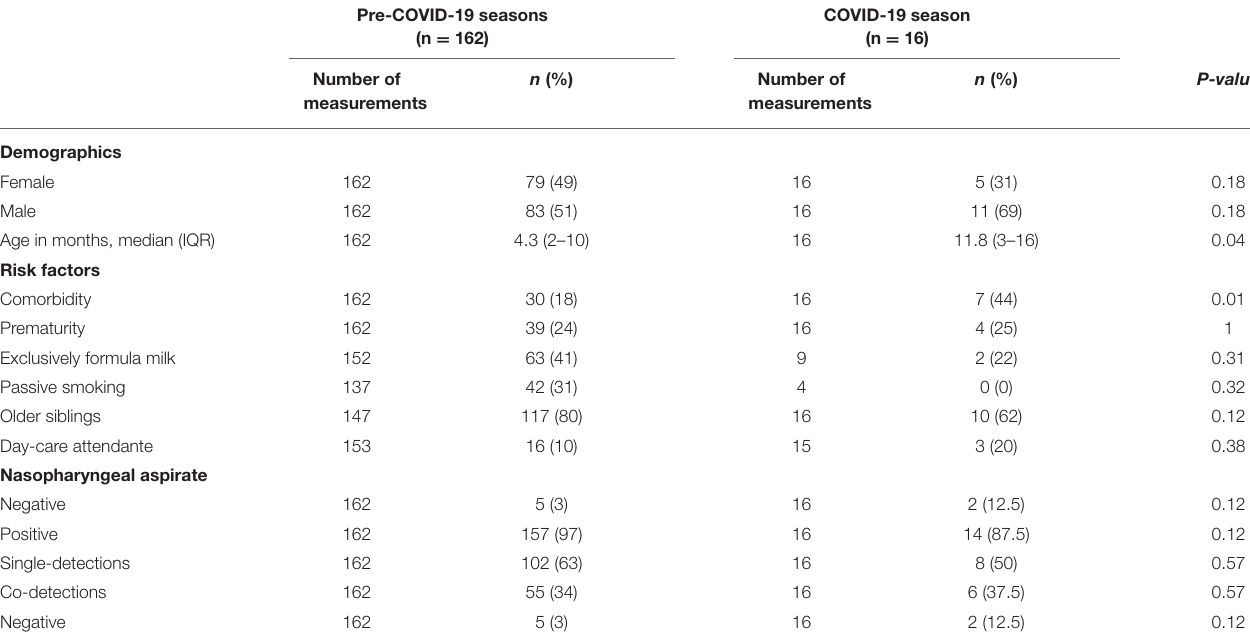
TABLE 1 | Viral detections, demographic characteristic and risk factors in pre-COVID-19 seasons and 2020/2021.